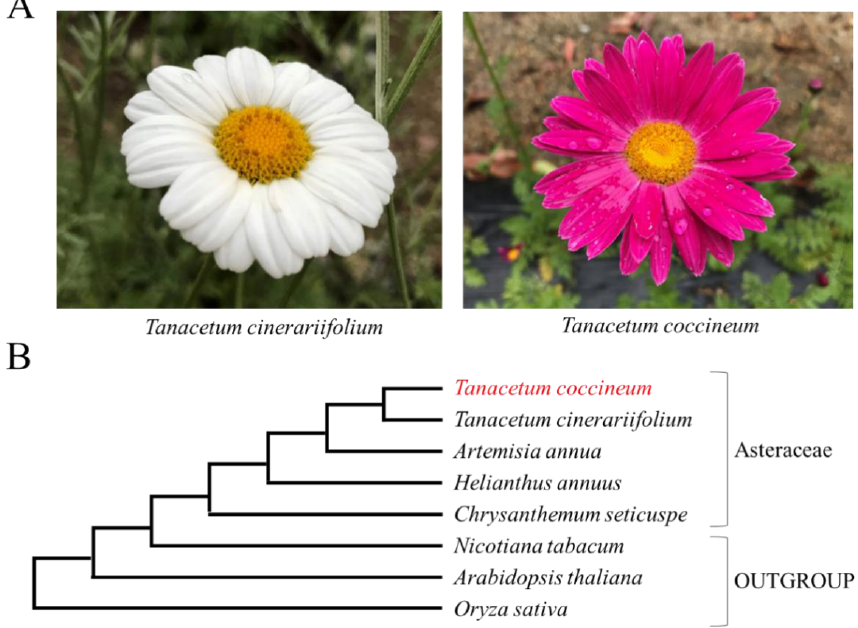
Figure 1. ( A ) Flowers of Tanacetum cinerariifolium and Tanacetum coccineum . ( B ) The